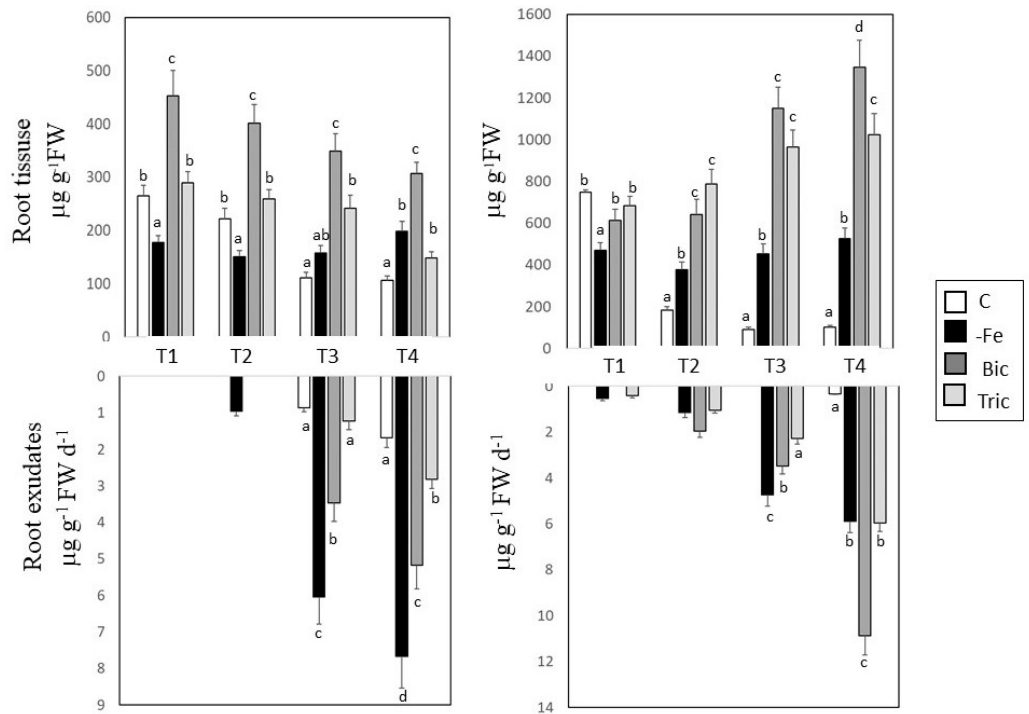
Figure 3. Time course of the concentrations of malic and citric acids in root tissues and exudates of plants grown in control conditions (C), direct iron deficiency conditions (–Fe), and under induced Fe deficiency in presence of bicarbonate (Bic) or alkaline organic buffer (Tric). Malic acid contents are reported in the left panels; citric acid contents are reported in the right panels. T1, T2, T3, and T4 correspond to sampling at 1, 3, 5, and 7 days. Data are the means ± SE (standard error) ( n = 5). Different letters indicate statistical differences ( p < 0.05) within each treatment.